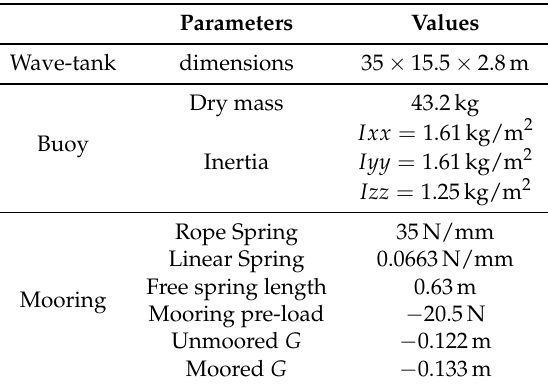
Table 1. Wave-tank and X-MED details.